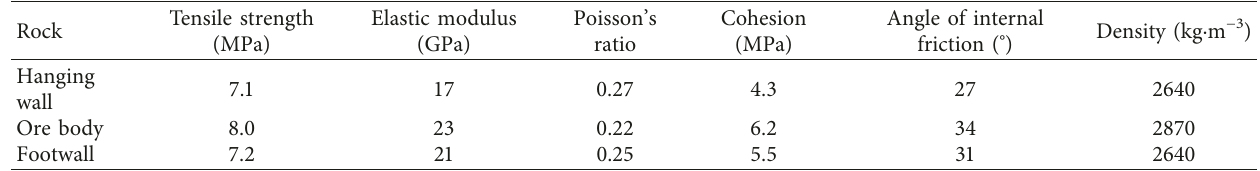
Figure 3: Establishment of the simulation model. (a) 3D model. (b) Intact rock. (c) Fractured rock. Table 1: Rock parameters in the calculation model.